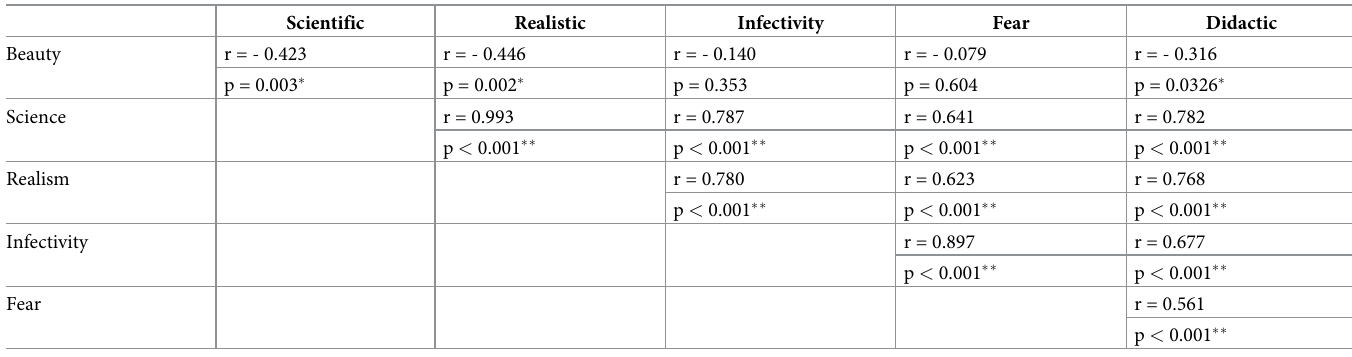
Table 2. Correlations among categories.